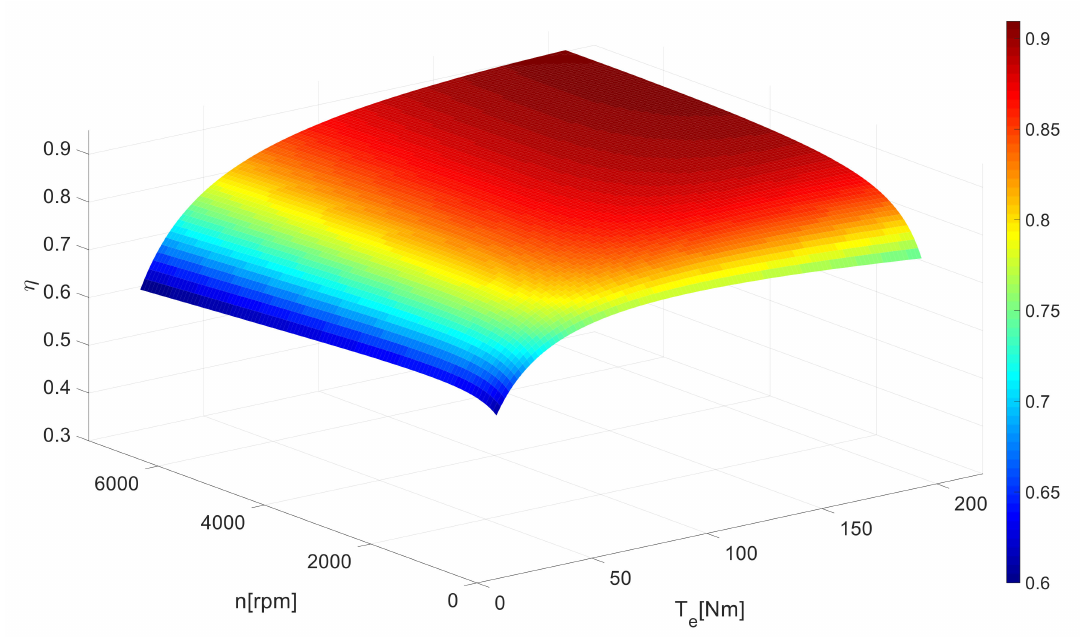
Figure 4. Surface of system efficiency in the whole rated operating